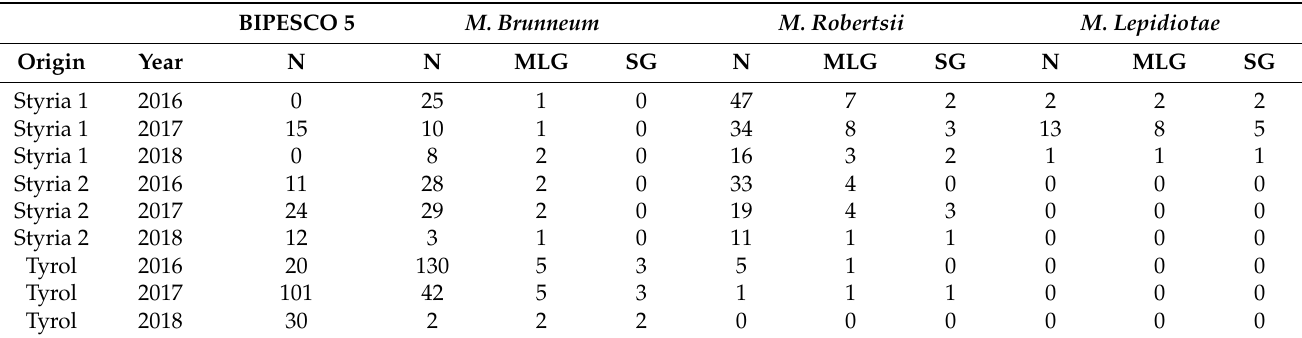
Figure 4. Minimum spanning network (MSN) showing the relationship between the SSR genotypes isolated from the treated field sites (Styria 1, Styria 2, and Tyrol). Circle sizes are proportional to the number of isolates belonging to one MLG, the thickness of the line is proportional to genetic SSR based similarity of genotypes. MLG 24 represents the genotype of the applied strain BIPESCO 5. Table 2. Numbers of isolates and MLG identified as M. brunneum , M. robertsii , or M. lepidiotae from the treated field sites. The applied strain BIPESCO 5 is shown separated from M. brunneum .